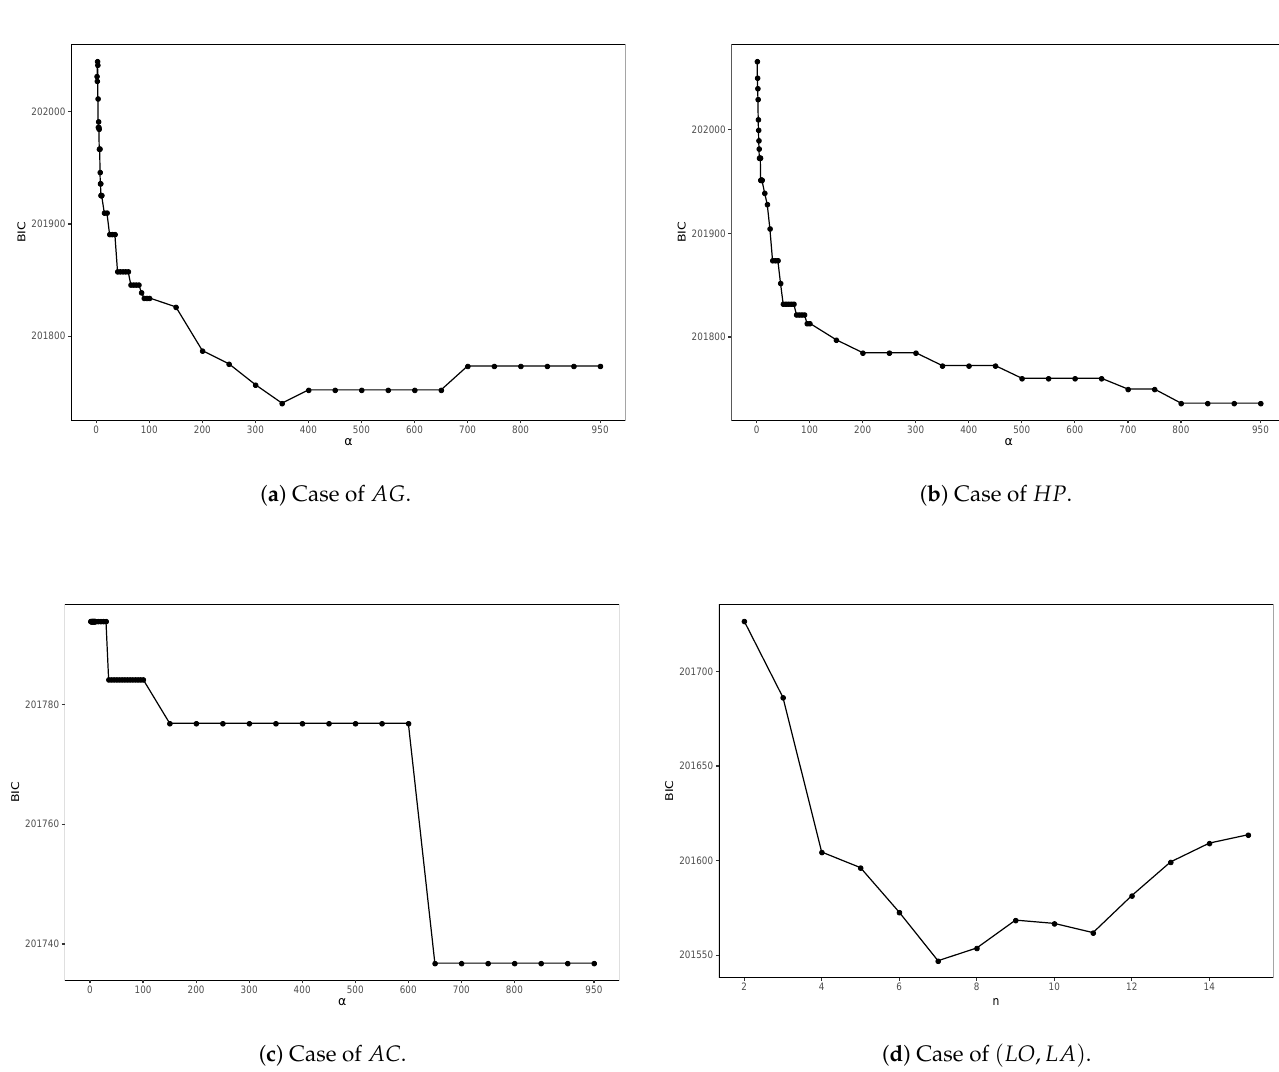
Figure 4. Illustration of the BIC as a function of the penalization parameter α for the evolutionary trees in the case of AG , HP and AC and as a function of the number of bins n for Fisher’s natural breaks in the case of ( LO , LA )